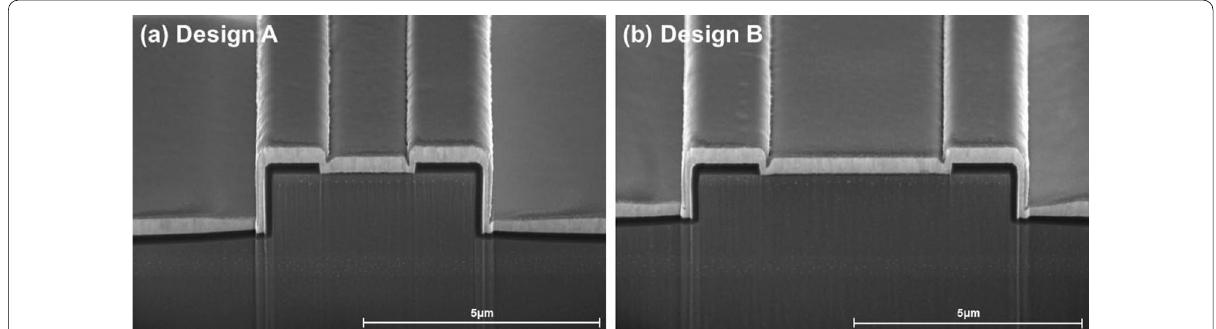
Fig. 3 Cross-sectional SEM images of optimized RW lasers: a Design A and b Design B